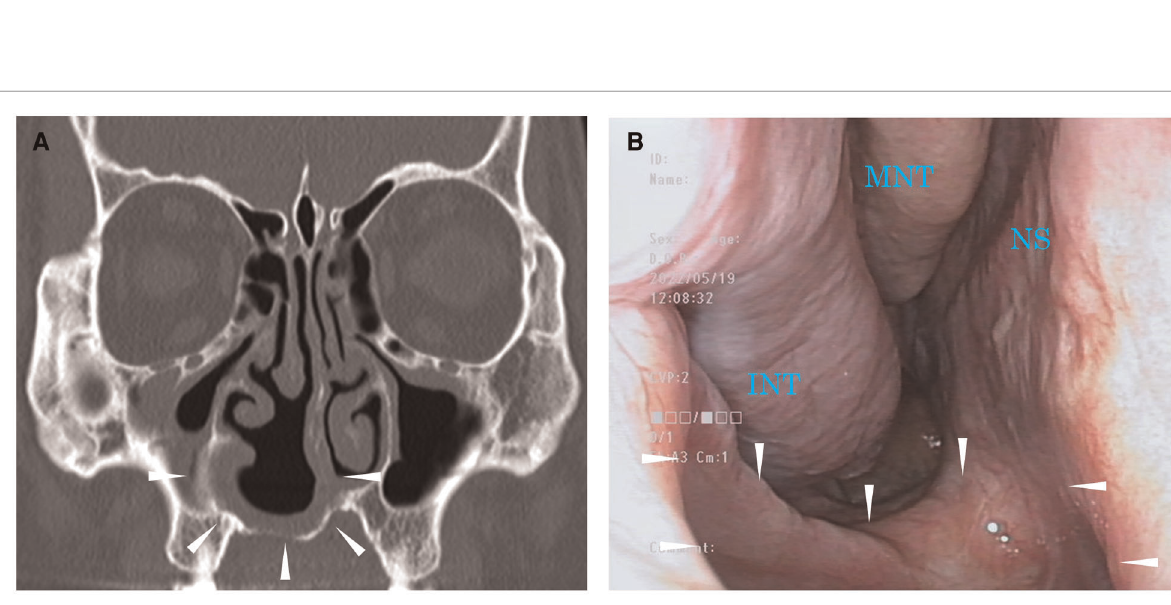
FIGURE 3 Hematoxylin and eosin-stained section of the resected cyst (scale bar=250 μ m). ( A, B ) Show weakly and highly magni fi ed images, respectively. The cyst was lined by a strati fi ed squamous epithelium with dense lymphocyte in fi ltration and fi brous tissue under the epithelium.